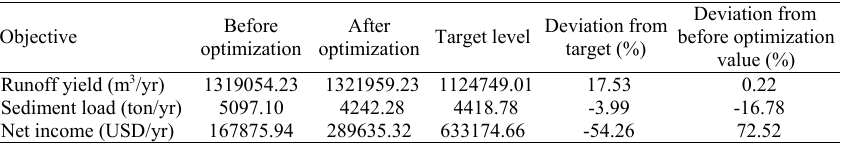
Table 6: Objective values in total watershed, before and after optimization